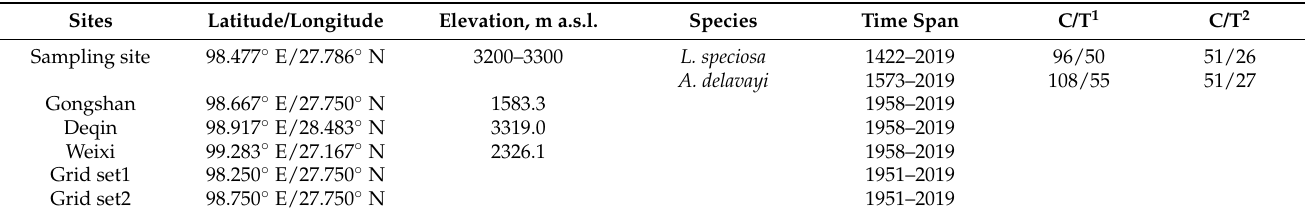
Table 1. Details of sampling site, meteorological stations, and grid points in the northwestern Yunnan